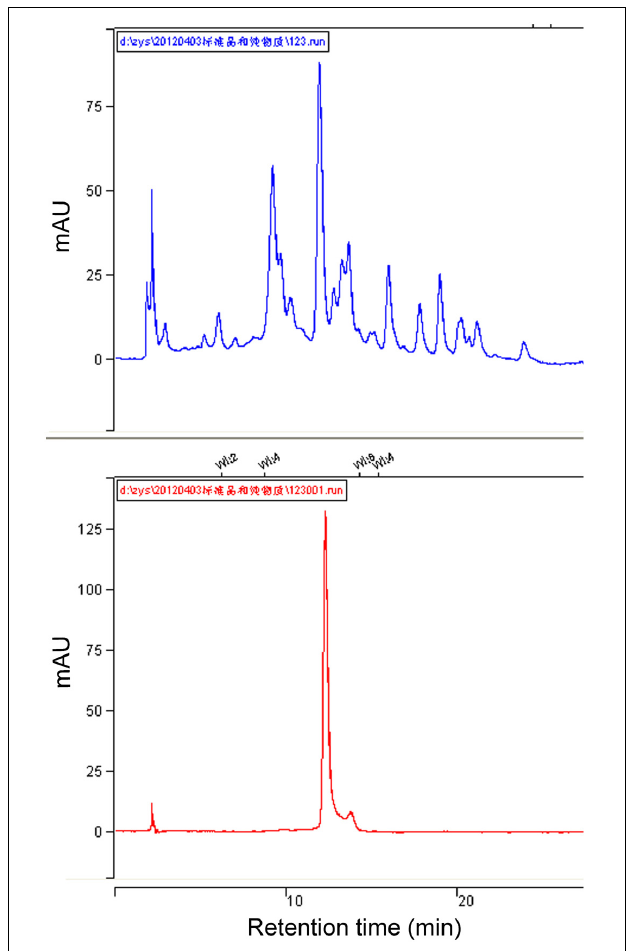
FIGURE 5 | HPLC chromatographs of total flavonoids and the standard sample of schaftoside. Showing the Peak 1 related compound in the flavonoids of RHT rice variety (upper) has the same retention time with the standard sample of schaftoside (lower).